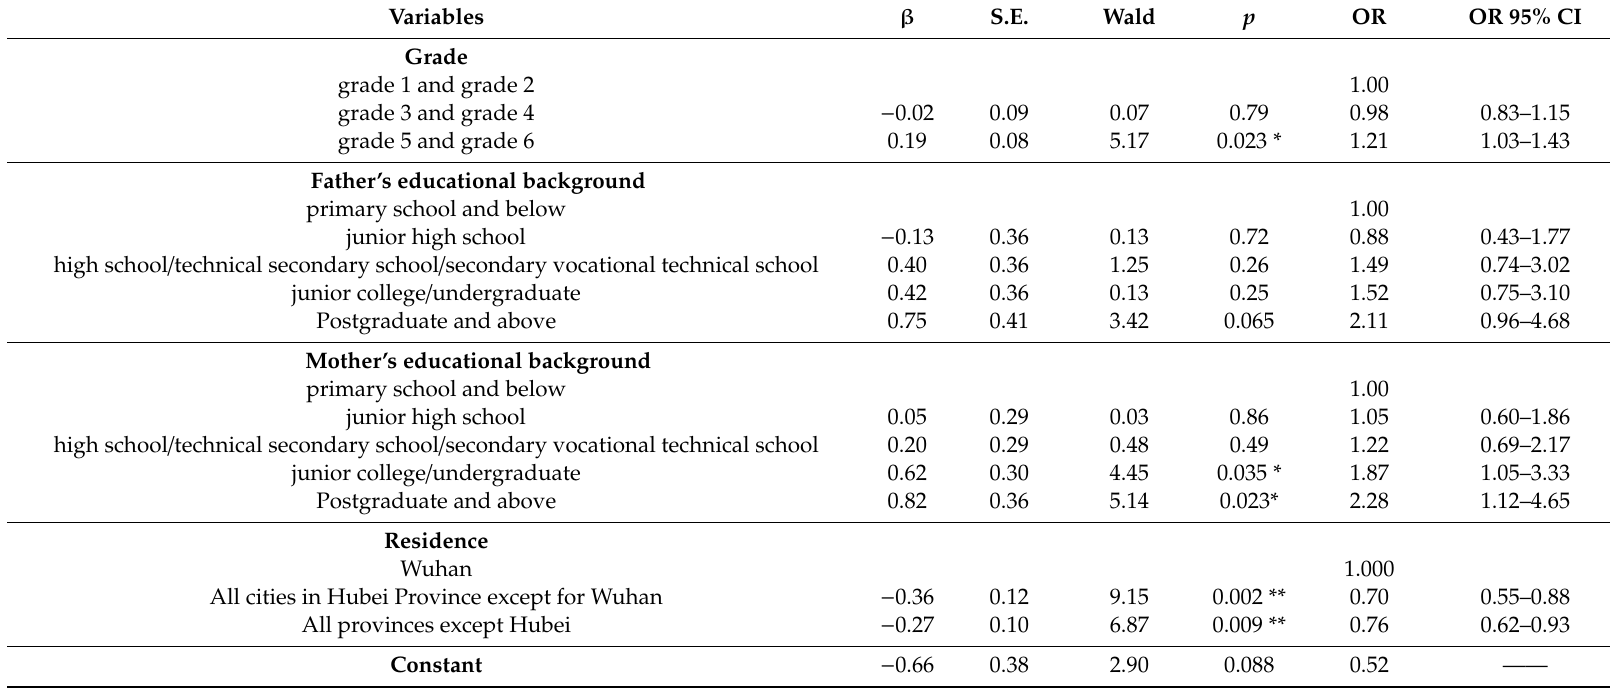
Table 3. Binary logistic regression analysis on the influencing factors of mask-wearing behavior ( n =